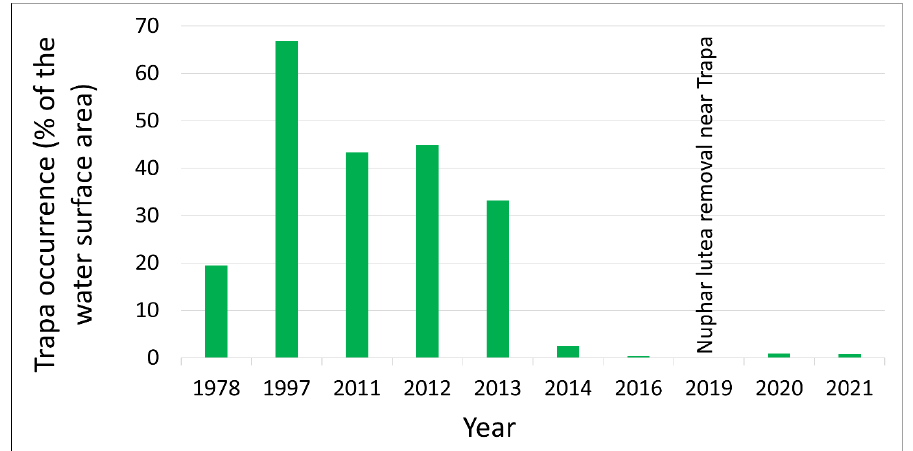
Figure 7. Changes in the distribution of T. natans in Nowoku ź nicki pond.